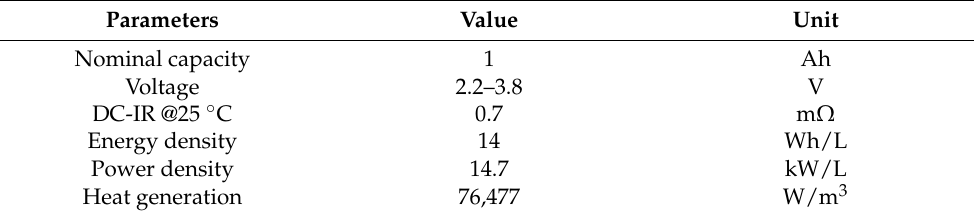
Table 1. LiC 2300 F specifications.